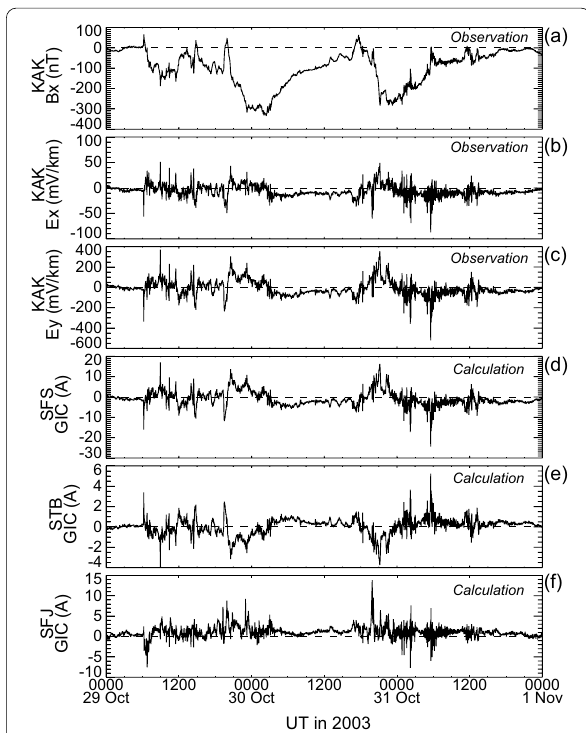
Fig. 7 Same as Fig. 6 except for the period of 29–30 October